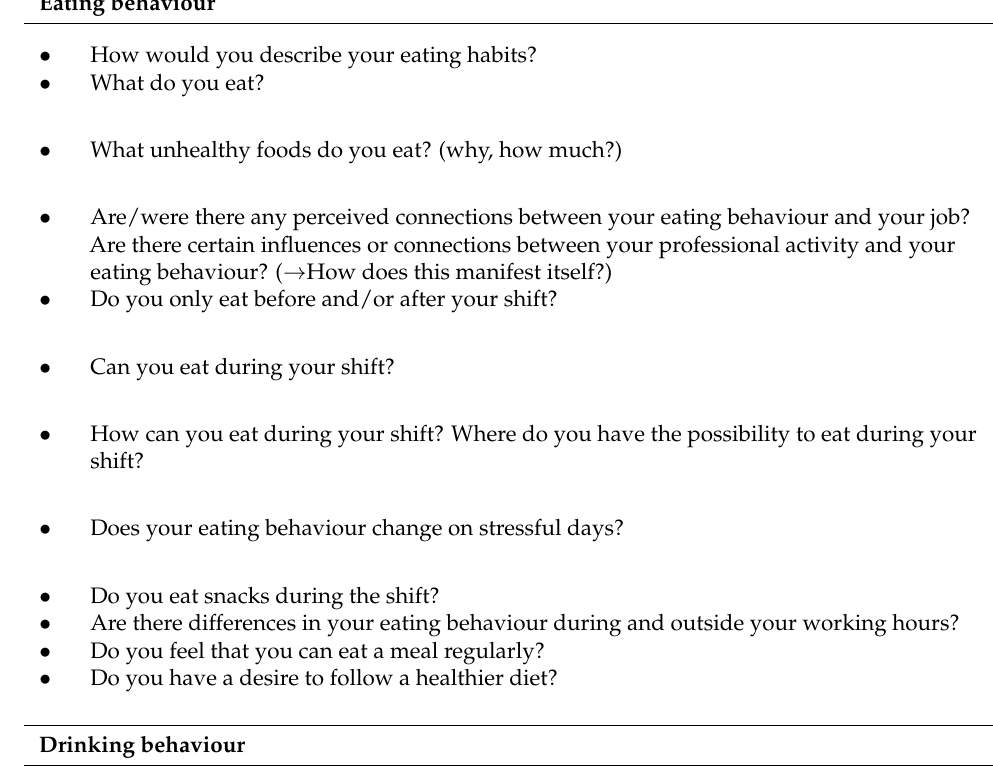
Table A1. Cont. Eating